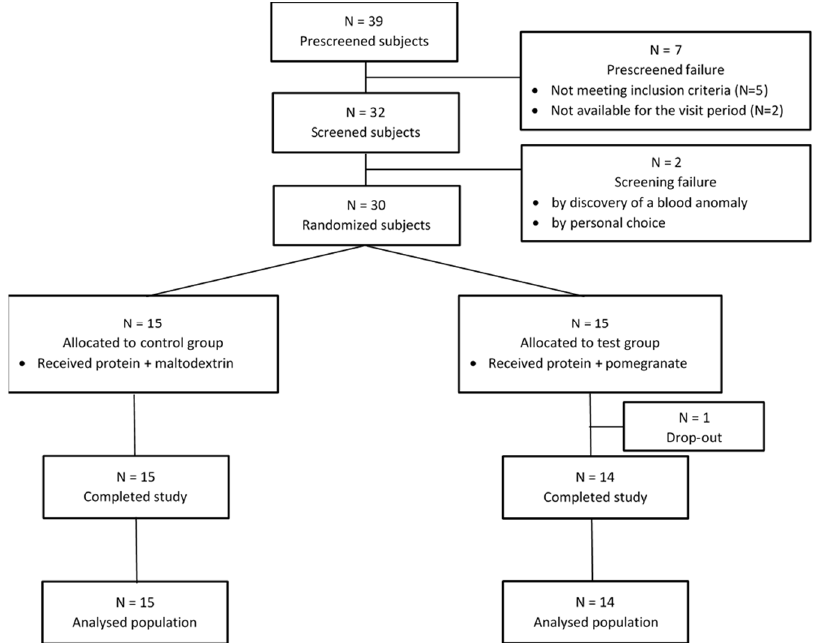
Figure 1. Flow chart of the study samples, including the number of participants who were screened, underwent randomization, completed the study treatment, and were analyzed for the primary and secondary outcomes.